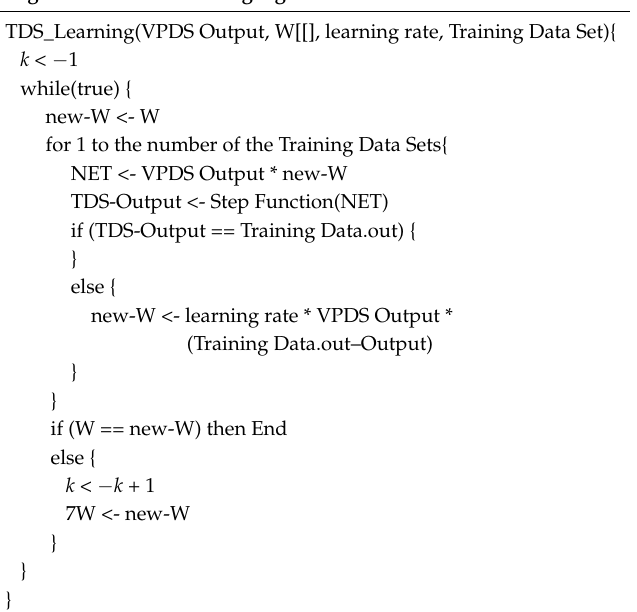
Algorithm 1. TDS learning